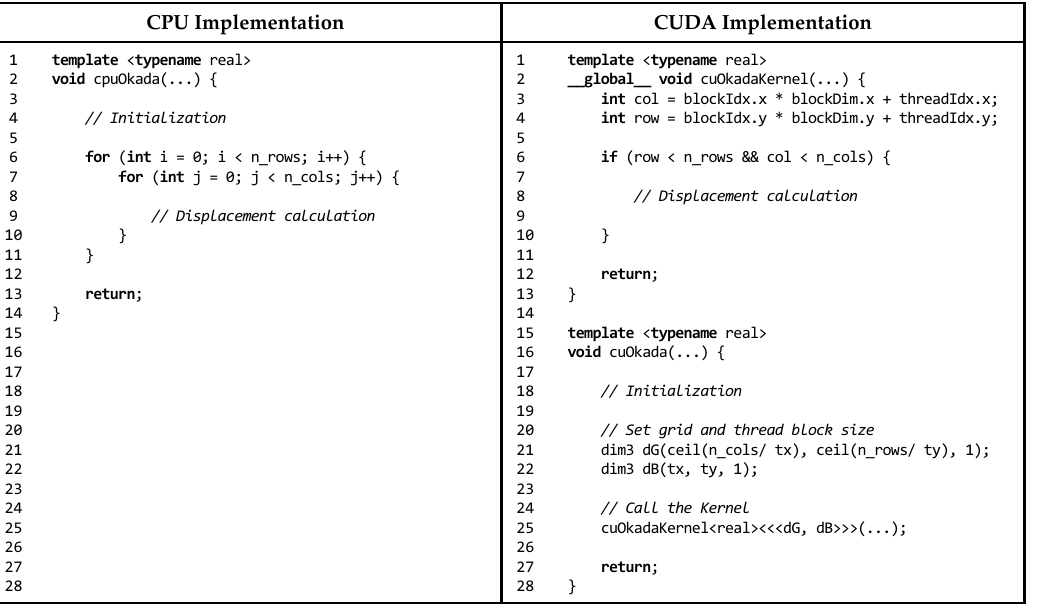
Figure 4. Difference between CPU and CUDA